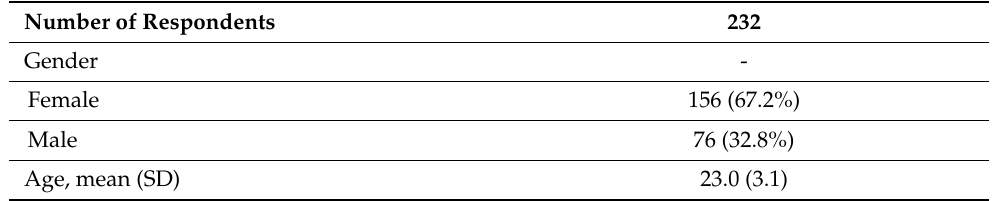
Table 1. Respondents’